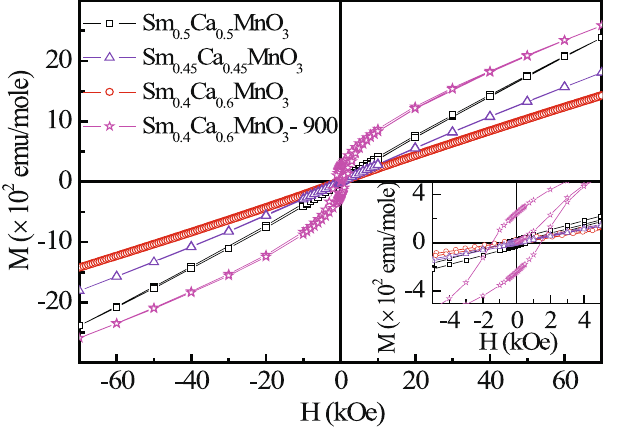
Figure 2. Magnetization as a function of external magnetic field of bulk Sm 1 − x Ca x MnO 3 (x = 0.5, 0.55, 0.6) and Sm 0.4 Ca 0.6 MnO 3 - nano compounds at T = 5 K. Inset shows the enlarged view of M(H) curves for low field